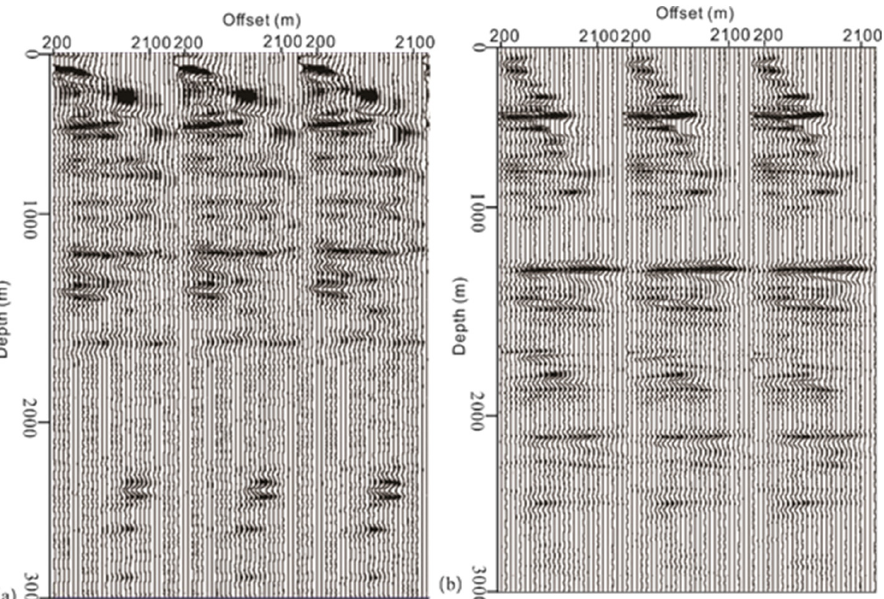
Figure 3. RTM SOGs calculated with attribute migration: ( a ) gathers at about CMP 150, and ( b ) gathers at about CMP 350.